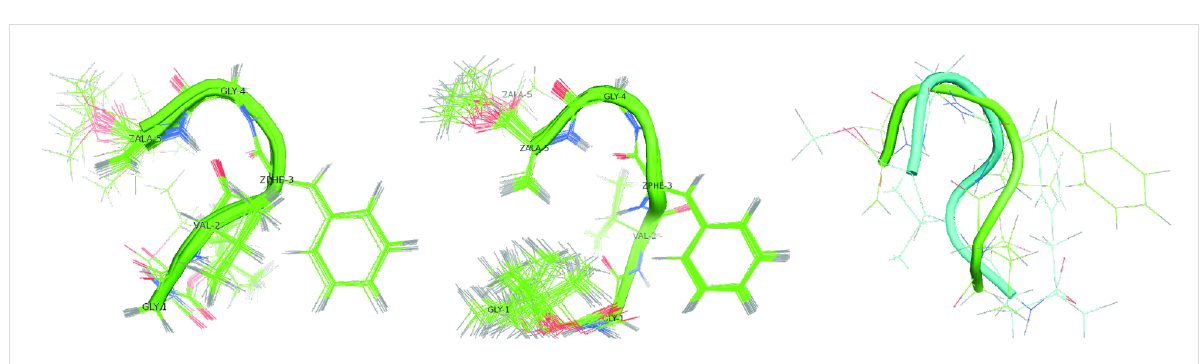
Figure 3: Proposal of the most stable conformation of peptide 2 based on XPLOR-NIH calculation. Conformation 2a (left), conformation 2b (middle) and a superposition of both conformation